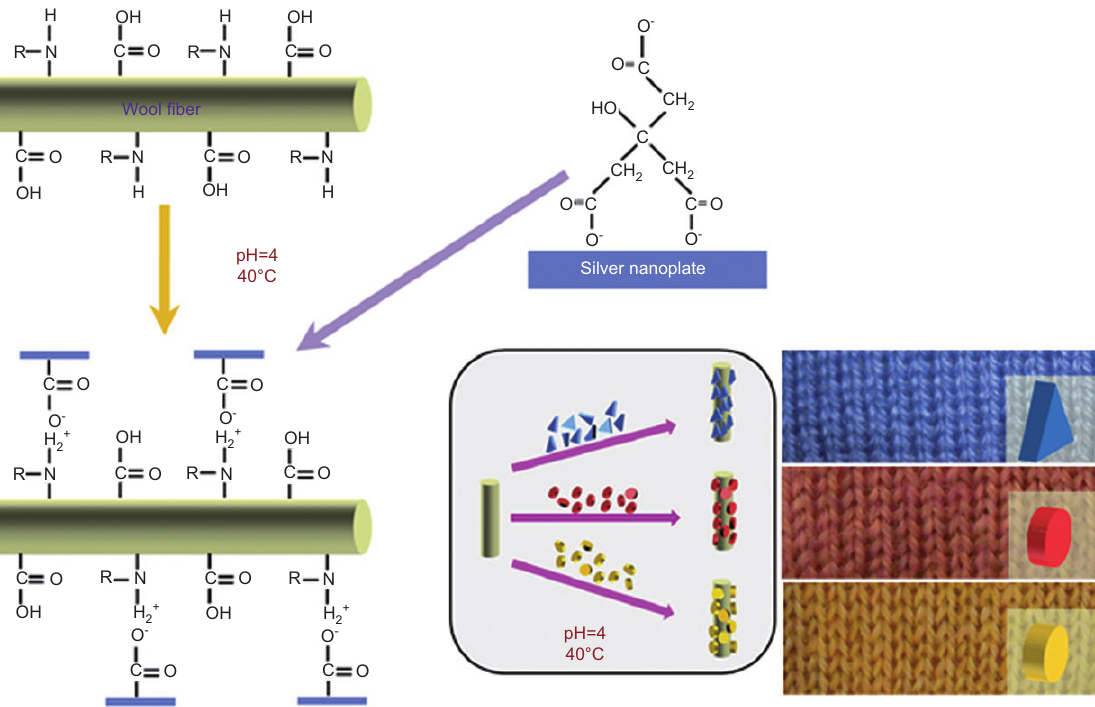
Figure 1 Coloration of wool fiber by using different silver NPs: (A) nanoprism I, (B) nanodisk I, and (C) nanodisk II. Reprinted from J. Colloidal Interface Sci., 2011, vol. 356, Tang B, Wang J, Xu S, Afrin T, Xu W, Sun L, Wang X, Application of anisotropic silver